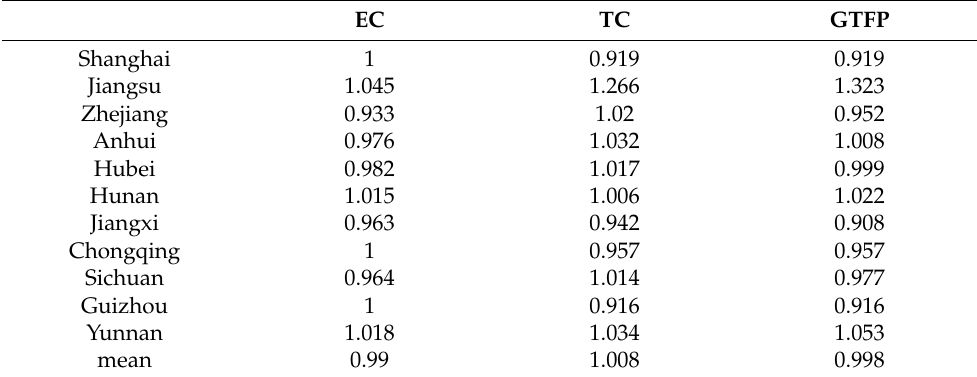
Table 3. GTFP of provinces and municipalities in the YREB and its